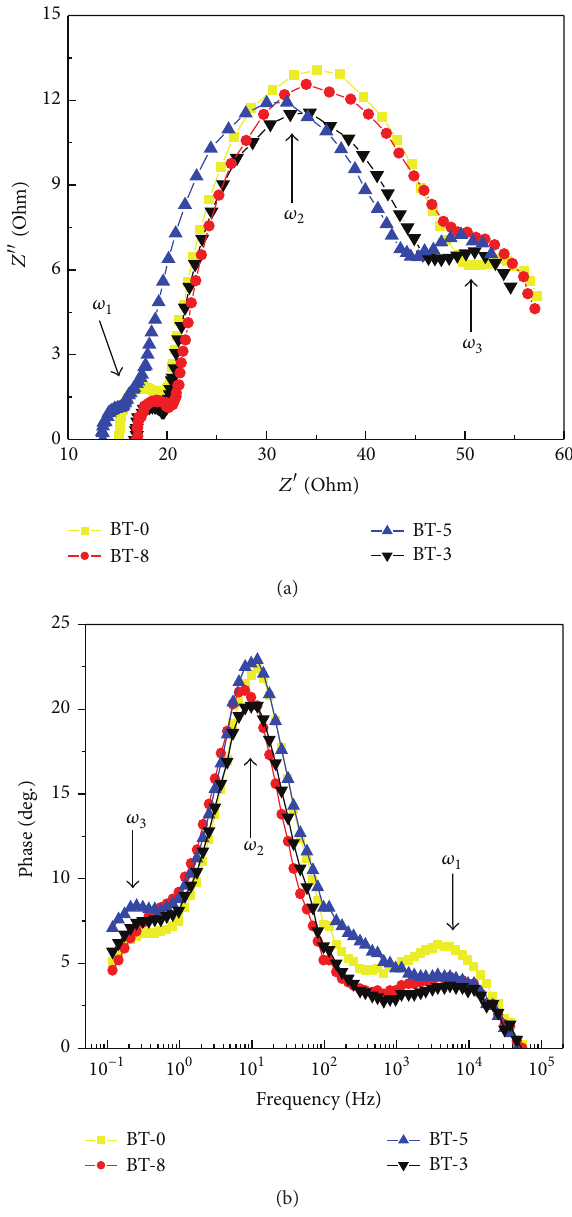
Figure 8: DSSC contains different B-TiO 2 . (a) Nyquist plot shows typical three arcs corresponding to specific resistance in photoanode-electrolyte-dye system, (b) Bode plot related to peak frequency represents electron